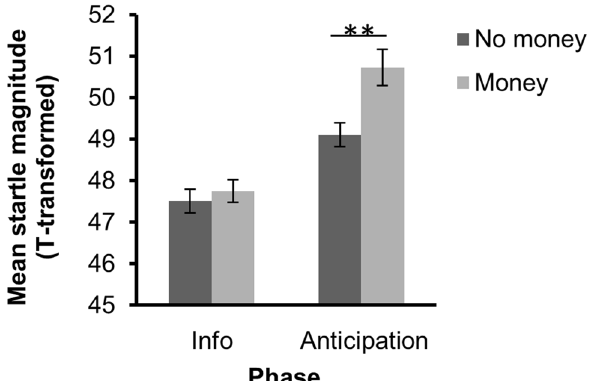
Figure 2. Mean startle magnitudes during the information phase and anticipation phase. Dark grey bars represent startle magnitudes in trials where no money could be won. Light grey bars represent startle magnitudes when there was a potential to win money. Startle magnitude was significantly increased when money could be won, compared to when no money could be won during the anticipation phase. The interaction between phase and win potential was significant ( p = .045). Error bars represent ± standard error of the mean. ** p < .01. Note that z -scores are transformed to t-scores for illustrative